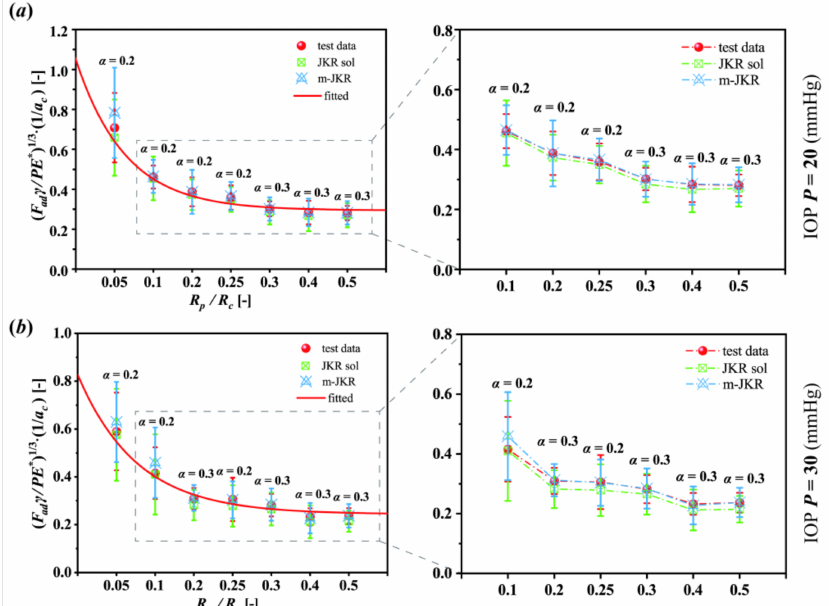
Figure 5. Normalization analysis of the scale effect of corneal adhesion: ( a ) under 20 mmHg, the fitting exponential function was y = 0.76 exp ( − 12.53 x ) + 0.29; ( b ) under 30 mmHg, the fitting exponential function was y = 0.58 exp ( − 10.49 x ) + 0.24. The data are presented as the mean ± SD; JKR sol and m-JKR indicate the solutions from the JKR and modified JKR models,